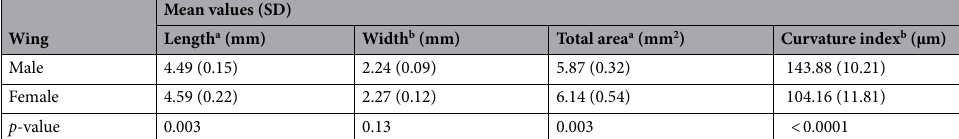
Table 1. Anatomical characteristics of male and female wings of B. oleae. a For the length and total area of wings, the variances were unequal, and the non-parametric Mann–Whitney test was performed for comparison. b For the width and curvature index, the variances are equal and the Student’s t -test (two-tailed, unpaired data) was performed. n = 50; Level of significance α =